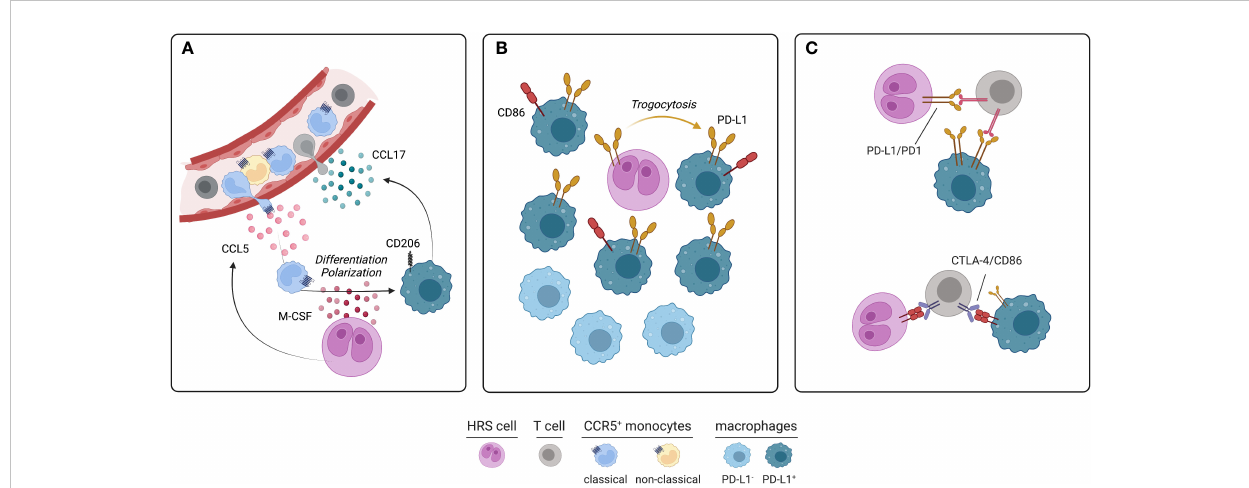
FIGURE 1 Soluble circuitries, spatial localization and speci fi c interactions of monocyte-macrophages in cHL. (A) Circulating CCR5 + classical monocytes, which are often more abundant in cHL than healthy subjects, are recruited into tumor microenvironment by CCL5 and other chemokines produced by HRS cells. Recruited monocytes undergo differentiation and polarization into immunosuppressive CD206 + TAM due to M-CSF exposure. In turn, TAM produce further chemotactic stimuli, such as CCL17, promoting the recruitment of T-cells, particularly Th2 cells. (B) PD-L1 + and PD-L1 - TAM are two different subsets populating different areas of immune microenvironment. Immunosuppressive, PD-L1 + TAM, sometimes co-expressing CD86, lie in close proximity of HRS cells. PD-L1 is acquired by macrophages through trogocytosis. By contrast, PD-L1 - TAM are usually located more than 75 m m from HRS cells. (C) Speci fi c inhibitory interactions occurring between HRS, T-cells and TAM within tumor microenvironment. PD-1 expressed on T-cells interacts with PD-L1 of HRS cells and TAM. Similarly, CTLA-4 expressed on T-cells interacts with CD86 expressed on HRS cells and a subset of PD-L1 + TAM ( fi gure created using